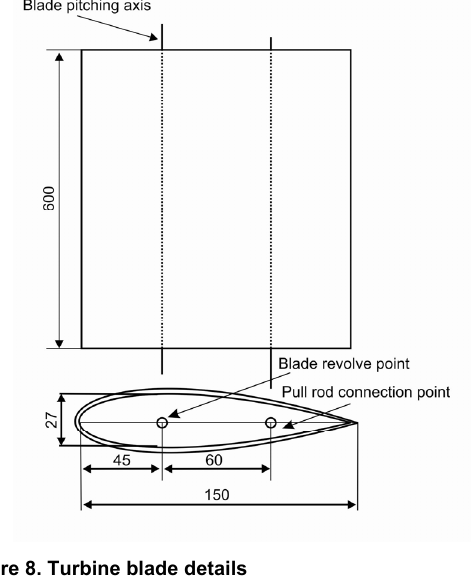
Figure 8. Turbine blade details